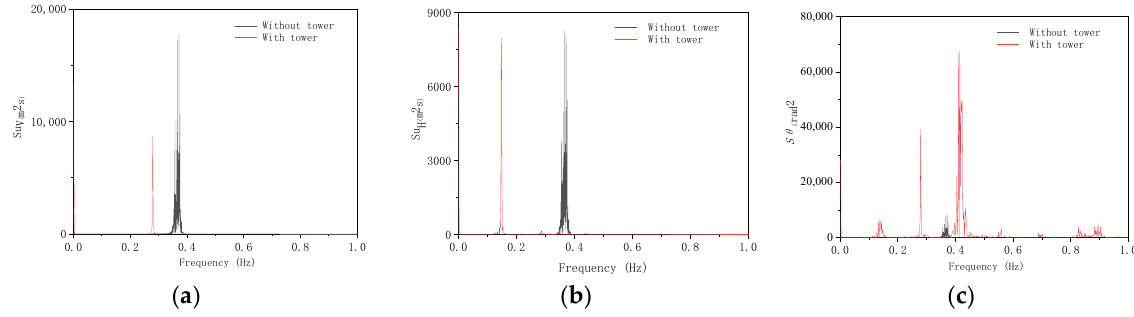
Figure 6. Spectrum comparison of the third span of conductor under wind velocity of 8 m/s With span length: 200 m: ( a ) Frequency spectrum diagram in vertical direction; ( b ) Frequency spectrum diagram in horizontal direction; ( c ) Frequency spectrum diagram in torsion.